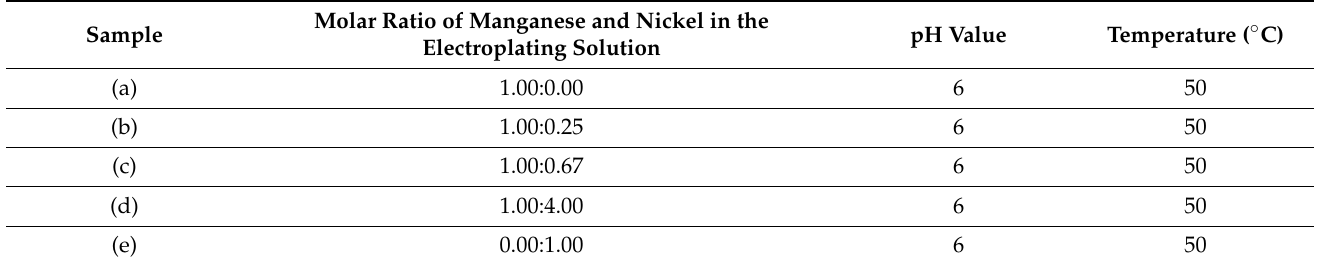
Table 1. Reaction parameters for the